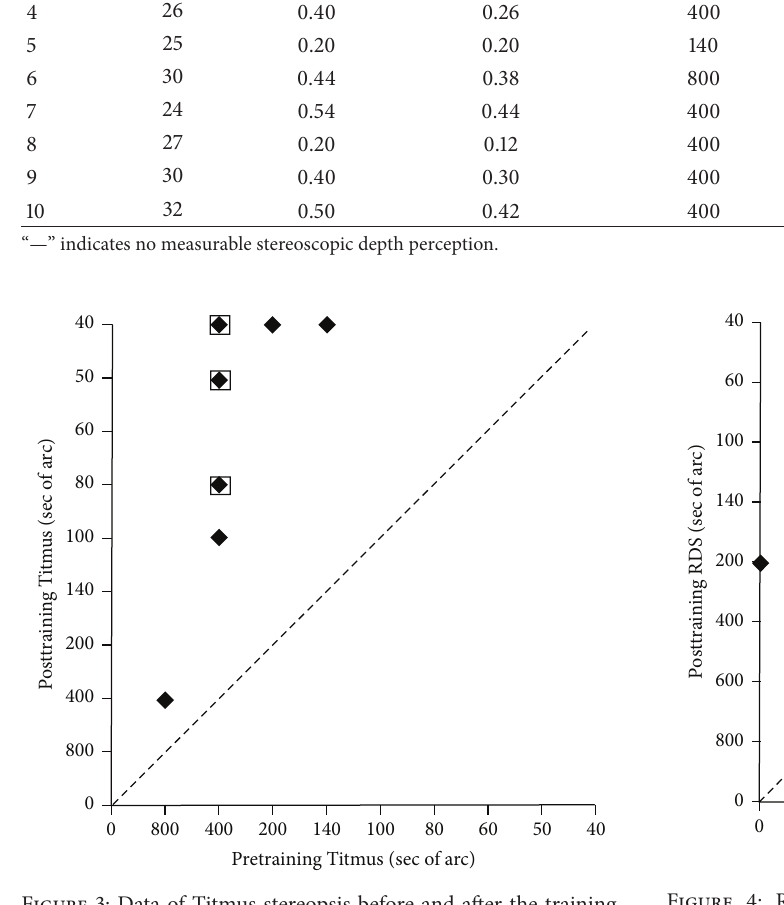
Figure 3: Data of Titmus stereopsis before and after the training. The x -axis represents the stereopsis of the subjects before the treatment and the y -axis represents the stereopsis of subjects after the treatment. Stereopsis of Titmus was significantly improved after the treatment ( 𝑃 = 0.005 ). A square outline represents two overlapping data points.